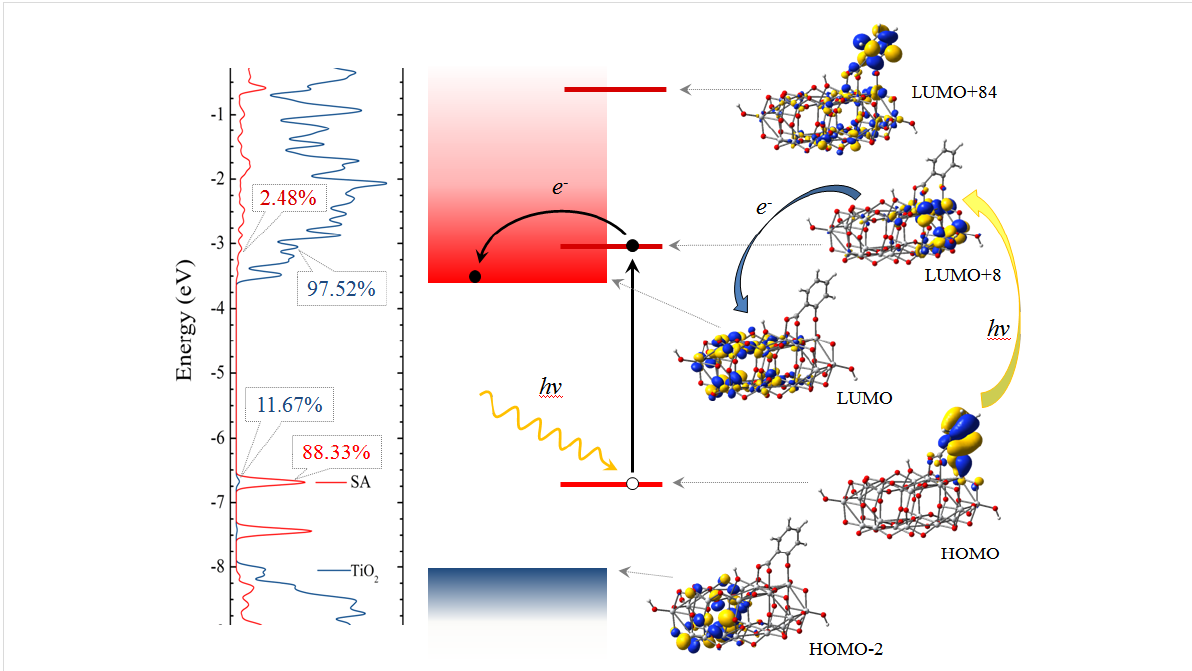
Figure 10: Schematic illustration of electro-optical processes that initiate the photocatalytic degradation of transparent pollutants on titania: (left) density of states, revealing the mixed character of the key MOs, (center) diagram showing the energy level alignment, the photoexcitation and the charge transfer, and (right) the molecular orbitals, showing the anchoring geometry and the charge localization.